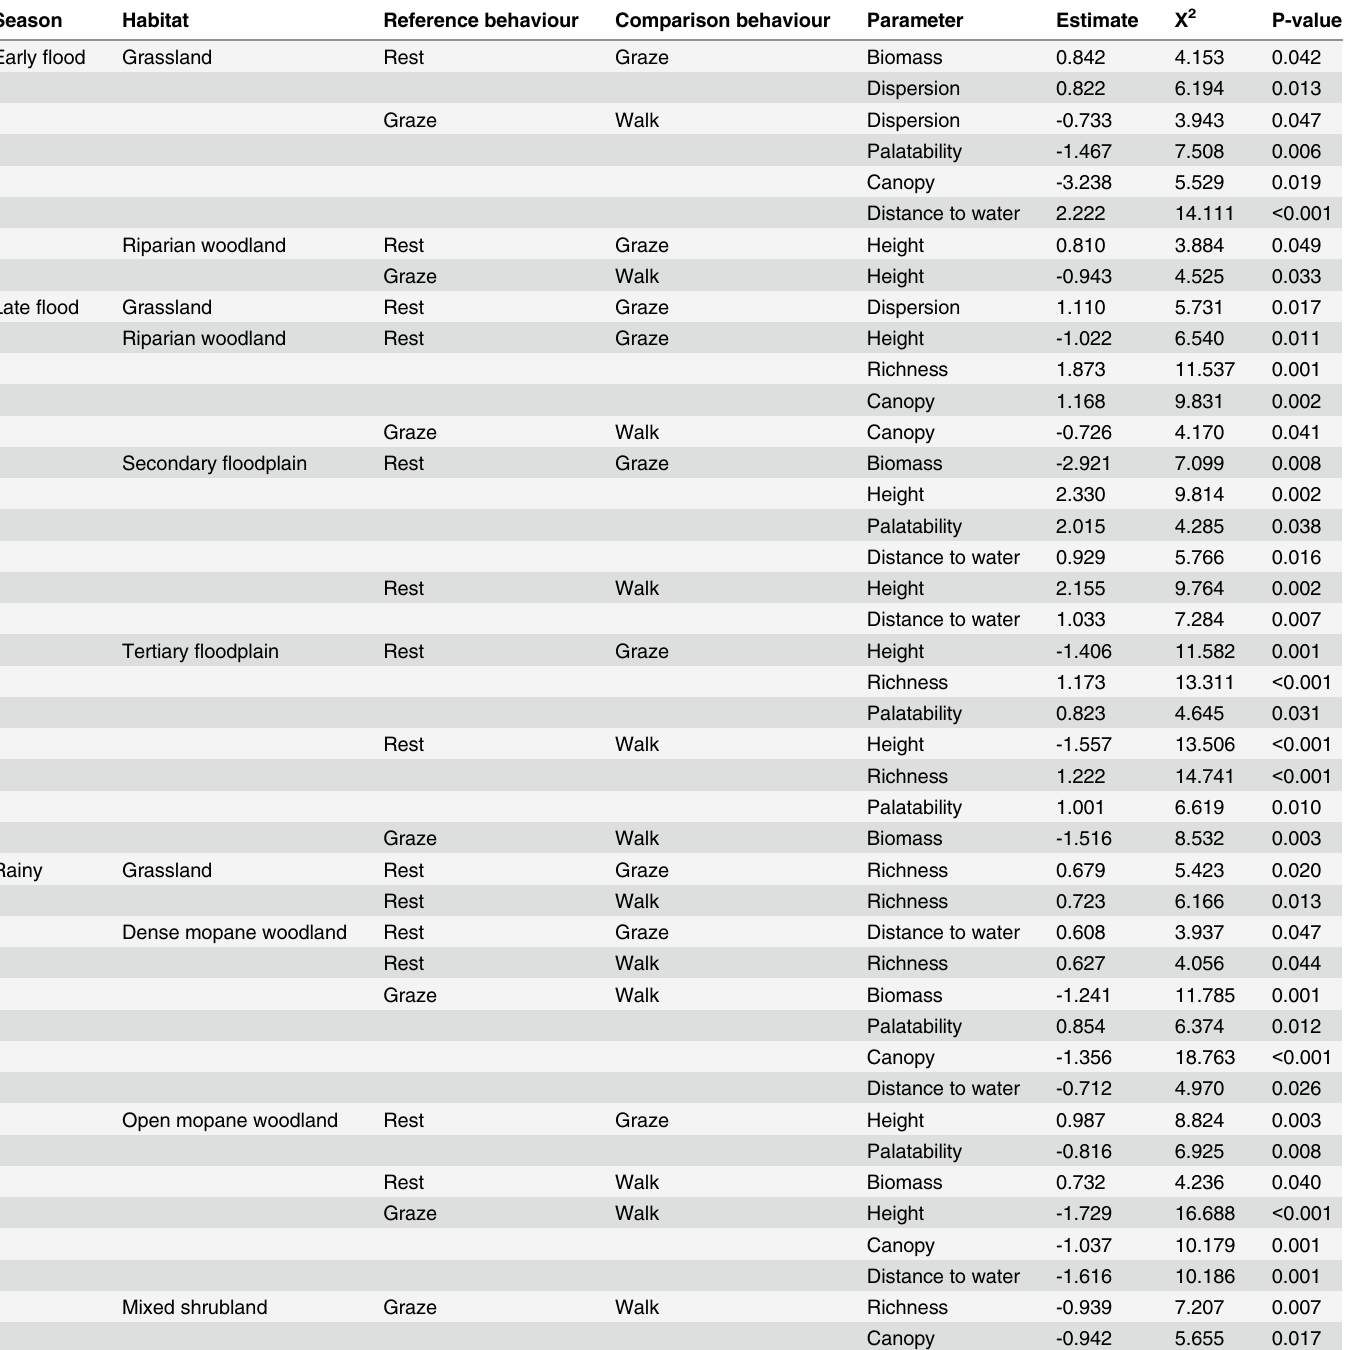
Table 7. Vegetation characteristics differing significantly between microhabitats used for different